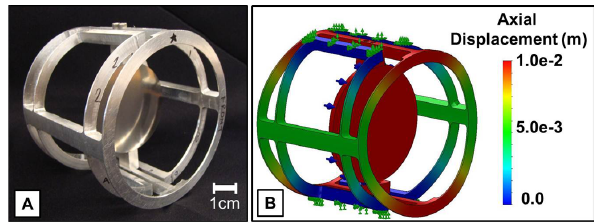
Figure 1. The quad compound-spring cylindrical flexure, CF, ex- ample: (A) 7075Al prototype and (B) FEA model depicting its ac- tuation.